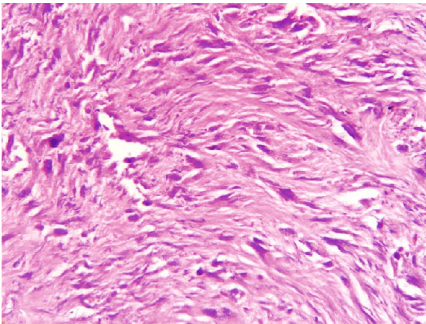
Figure 5: Poorly di ff erentiated malignant mesenchymal tumor. Multiple sites of cellular and nuclear polymorphism are observed. Hematoxylin-eosin staining, × 100.